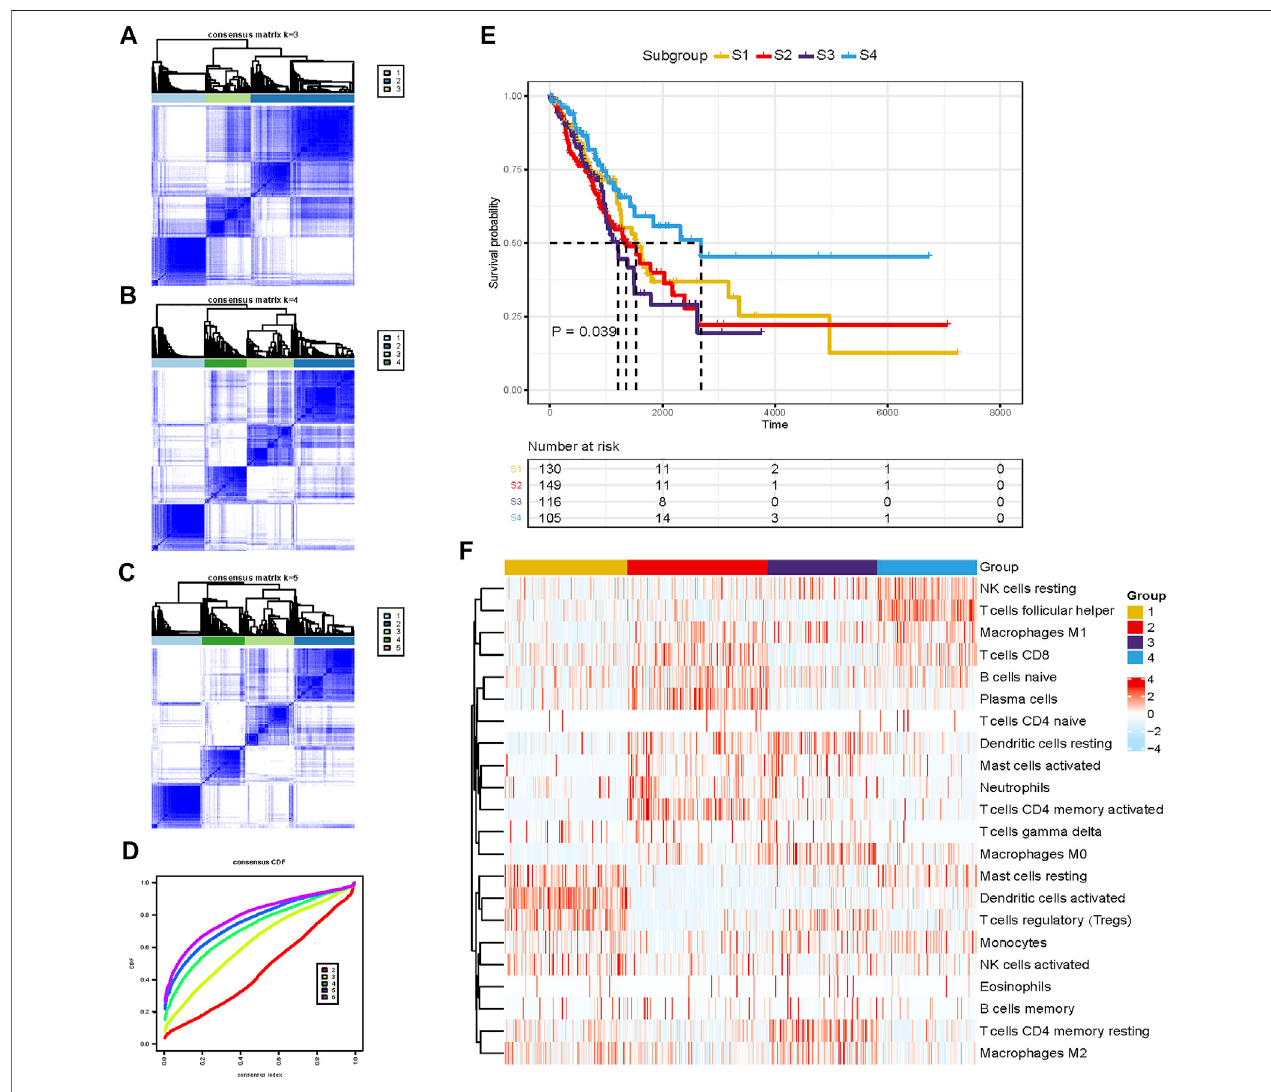
FIGURE1| Unsupervisedclusteringofthe tumor microenvironment (TME)cells for500patientsinthe TCGA-LUADcohort. (A – C) Consensus matrices ofdifferent clusters. (D) Consensus cumulative distribution function (CDF) curve. (E) Kaplan – Meier (K-M) curves for overall survival (OS) of four different subtypes (log-rank test, p = 0.039). (F) Abundance pattern of 22 TME cell types in four TME